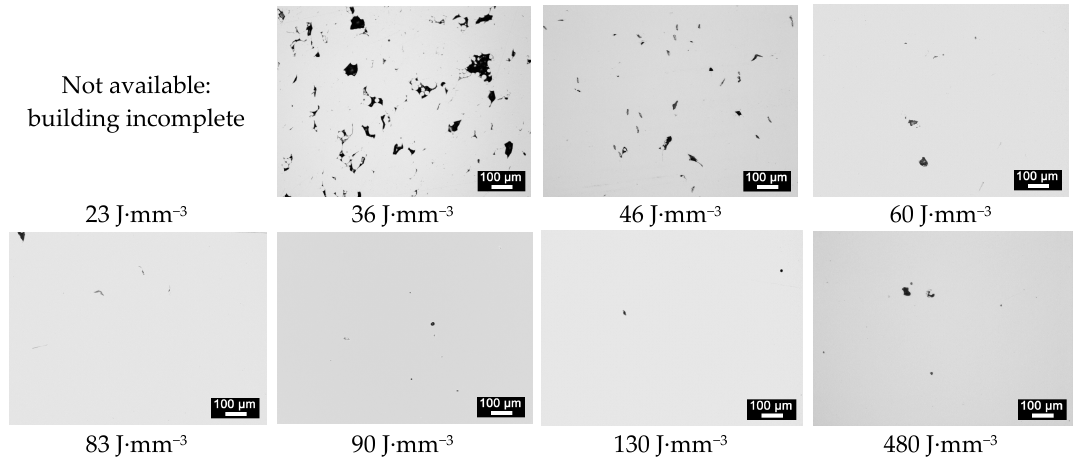
Figure 5. Micrographs of random cross ‐ sections for each condition of VED . Table 3. Average number of pores, size, and void fraction with corresponding dispersion.